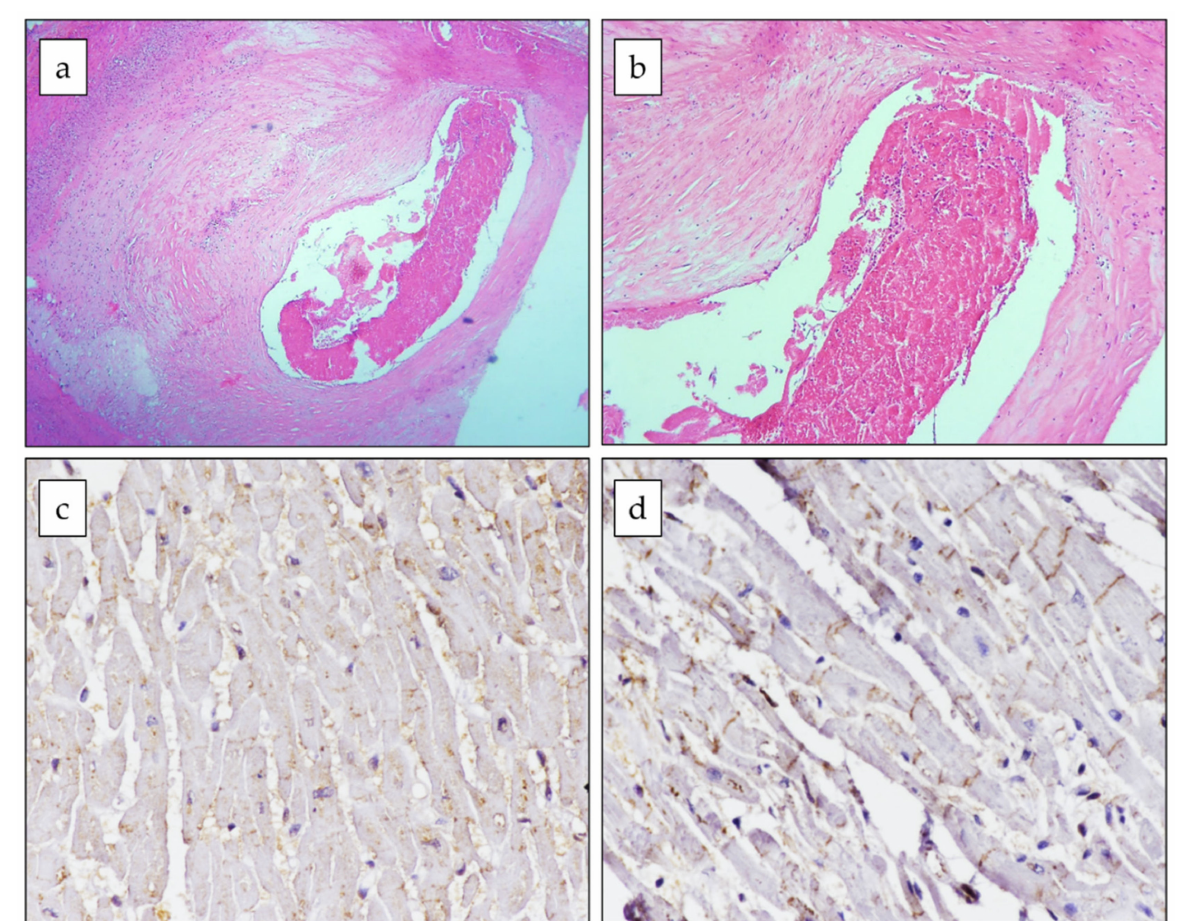
Figure 3. Histological and immunohistochemical features of case #4. A fresh sub-occlusive throm- bus ( a , b ) is shown in the lumen of the right coronary artery with fibroatheroma (hematoxylin–eosin staining, original magnification 4 × and 10 × , respectively); immunohistochemistry ( c , d ) showed phosphorylated (CX-43) and dephosphorylated connexin-43 (npCX-43) expressions in the ischemic myocardium (original magnification 40 × ). CX-43 was mainly localized to the cytoplasm ( c ), whereas npCX43 was mainly expressed at the intercalated disk and almost absent in the cytoplasm ( d ). Finally, the toxicological screening, anti-PF4 antibodies, and tryptase analyses yielded negative results in all of the cases. Through genetic testing, all of the subjects were identified as carriers of ≥ 1 MTHFR pro-thrombotic allele, and four individuals (#1, #2, #3, and #4) were also carriers of one or two PAI-1 4G alleles (Table